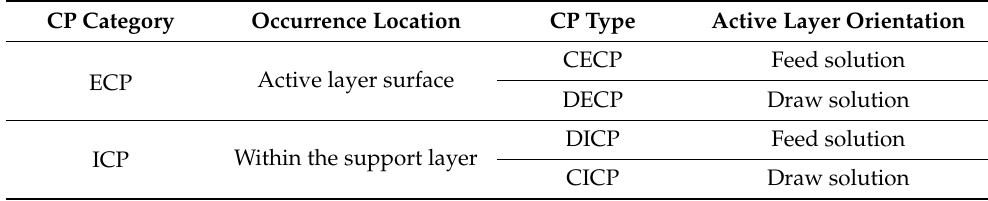
Table 3. Concentration polarization types based on active layer orientation.